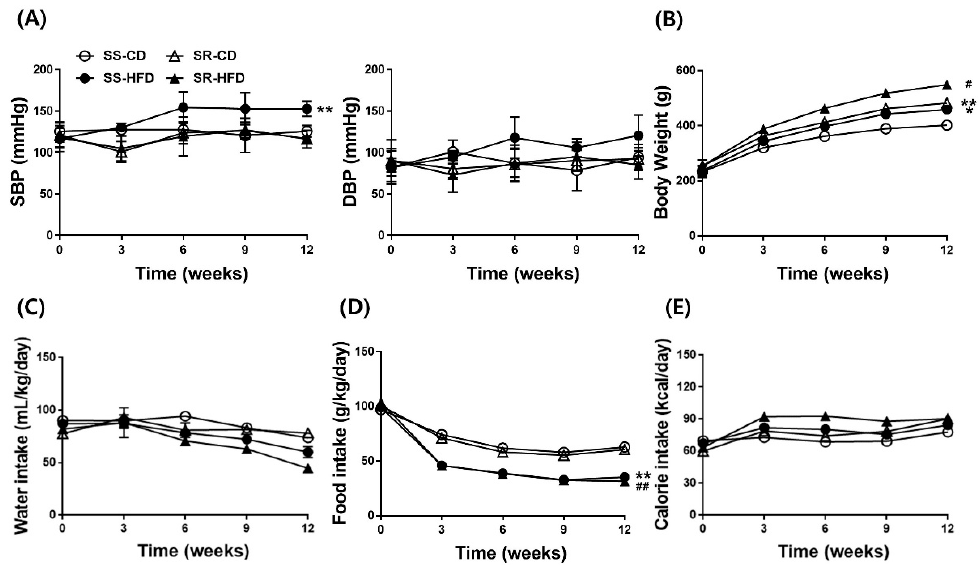
Figure 1. The effects of a high-fat diet on systolic blood pressure (SBP), diastolic blood pressure (DBP), body weight, water intake, food intake, and calorie intake in Dahl salt-sensitive (SS) and salt-resistant (SR) rats. SS and SR rats were fed either a chow diet (CD, 8.6% fat) or a high-fat diet (HFD, 60% fat) for 12 weeks. ( A ) The HFD increased the SBP in SS rats but not in SR rats. ( B ) The HFD increased body weight gain in both the SS and SR rats. ( C – E ) Water intake, food intake, and calorie intake are shown. As food intake decreased in the HFD groups, there was no difference in calorie intake between the CD and HFD groups. Graph, mean ± SEM of 6 independent experiments. Two-way analysis of variance followed by Tukey’s post hoc multiple comparisons test. * p < 0.05 and ** p < 0.01 vs. the SS CD group. # p < 0.05 and ## p < 0.01 vs. the SR CD group. ○, SS-CD; ●, SS-HFD; △, SR-CD; ▲, SR-HFD.